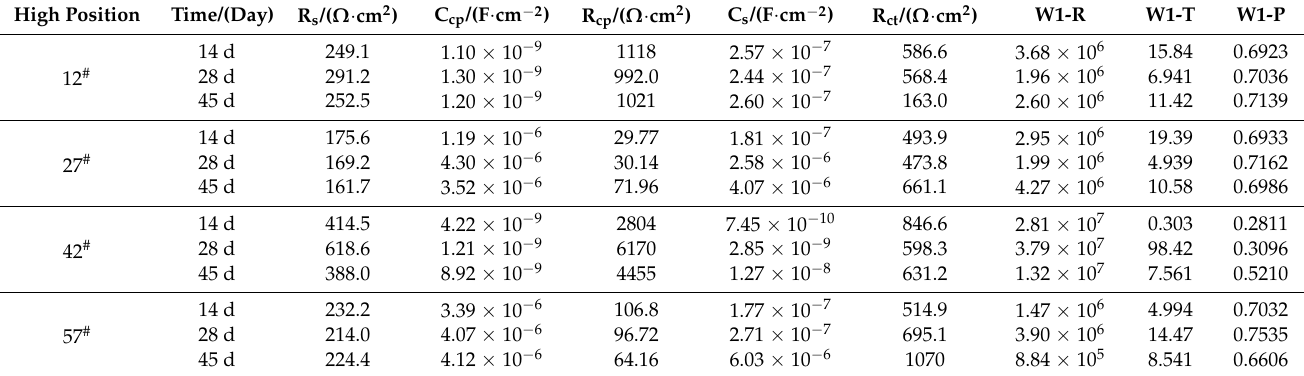
Table 7. Equivalent circuit parameters of X70 steel in soil with 0.3% sodium chloride